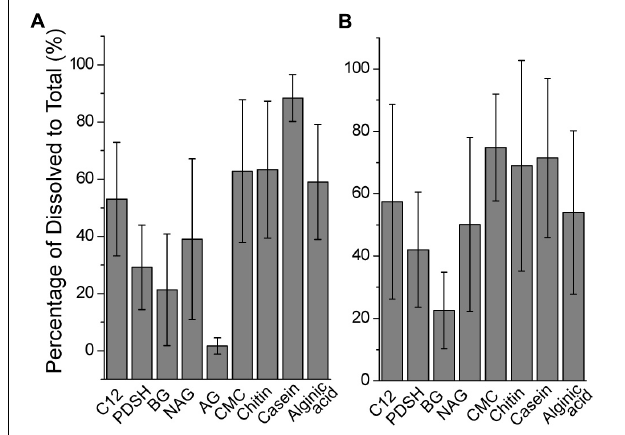
FIGURE 3 | The contributions of dissolved to total extracellular enzyme activities across stations. (A) At 35 ◦ C. (B) At 25 ◦